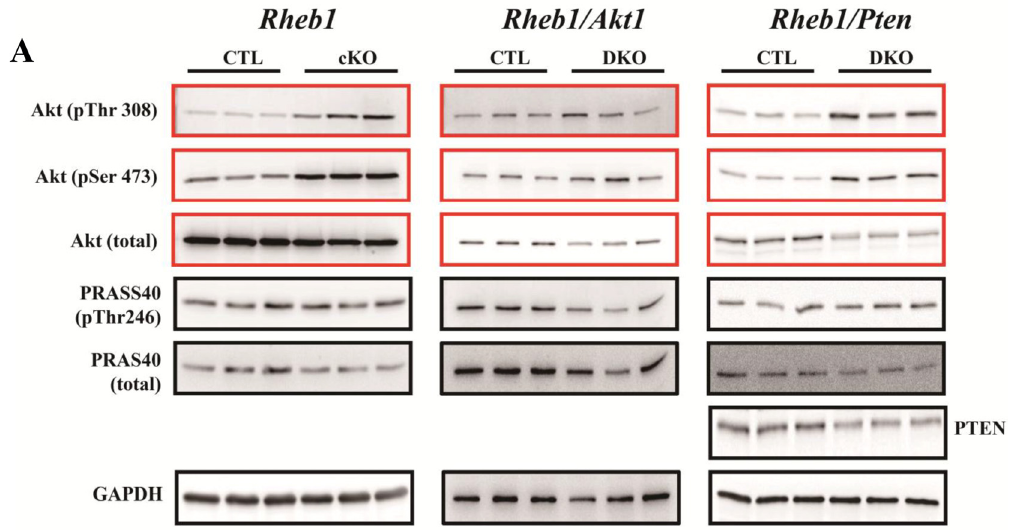
knockout and CTL (middle panel), and Rheb1 / Pten knockout and CTL mouse hearts (right panel) at post-natal day 9; ( B ) Quantitative comparison of levels of phospho-Akt and phospho-PRAS40 in each panel of ( A ) ( n = 3); ( C ) Quantification of PTEN in the right panel of (A) ( n = 3); ( D ) Quantification of total Akt in the medium panel of (A) ( n = 3); and ( E ) Survival analysis. Abbreviations: CTL, Control group ( Rheb1 F / F ); cKO, cardiac knockout group ( Rheb1 F / F ; α MHC-Cre); DKO, double knockout; PTEN, phosphatase and tensin homolog; PRAS40, proline-rich Akt substrate 40 kDa. * p < 0.05; ** p < 0.01; and *** p <